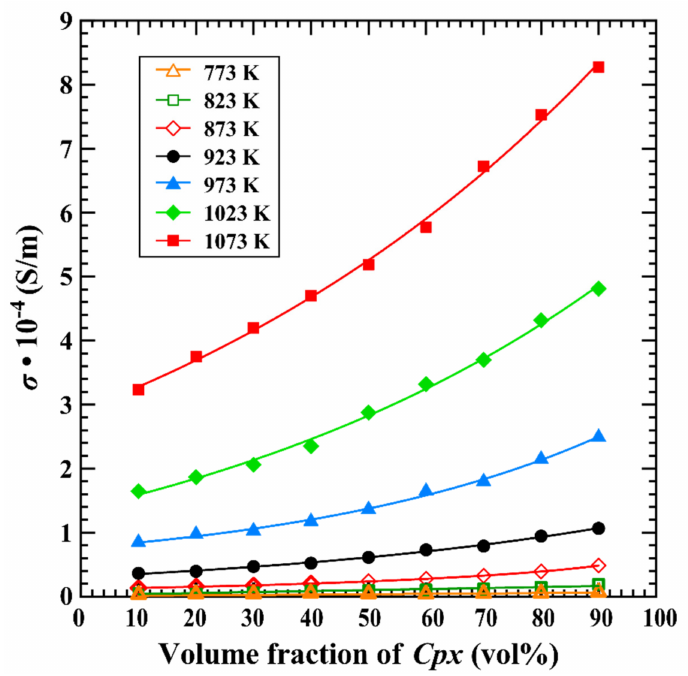
Figure 8. Effect of clinopyroxene content on the electrical conductivity of dry hot-pressed sintering gabbro samples with various mineralogical proportions at temperatures of 773–1073 K and 1.0